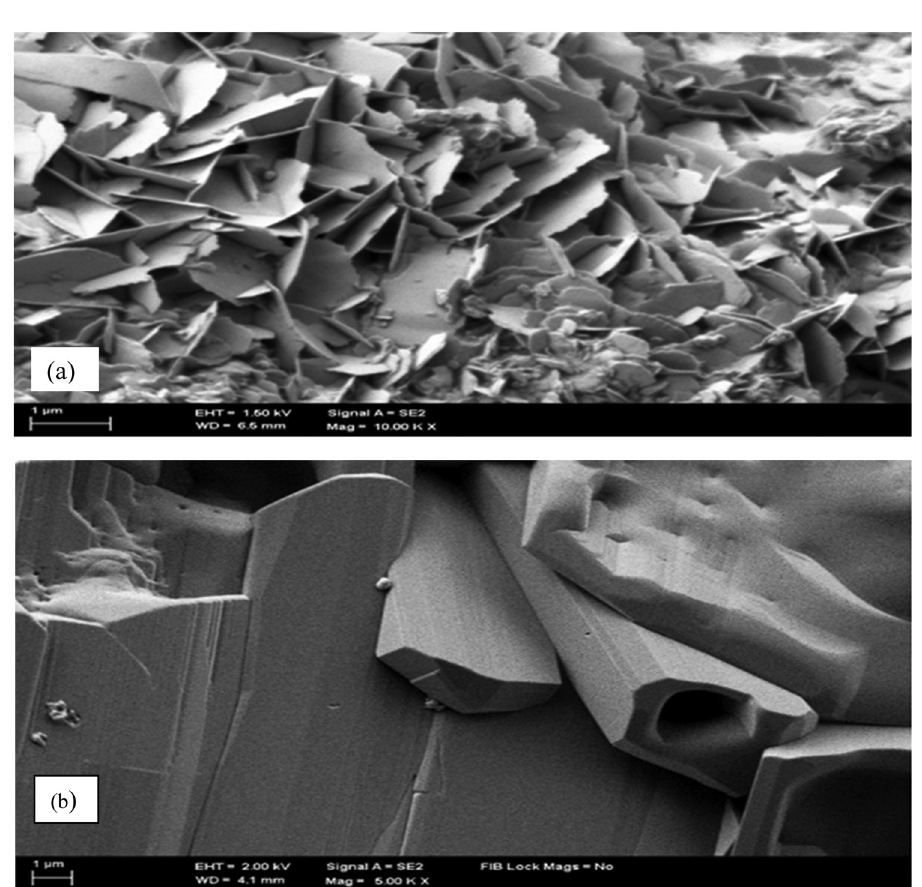
Figure 3: Structure of ZnO NSs – NTO: ( a ) zinc nanosheets layer; ( b ) disodium hexatitanate